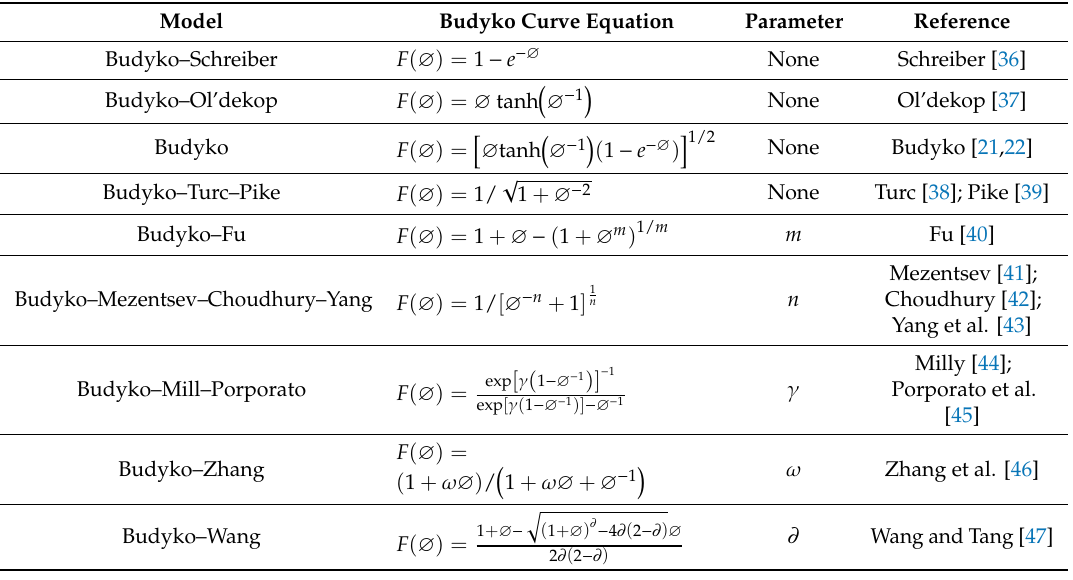
Table 1. Di ff erent models of Budyko curve